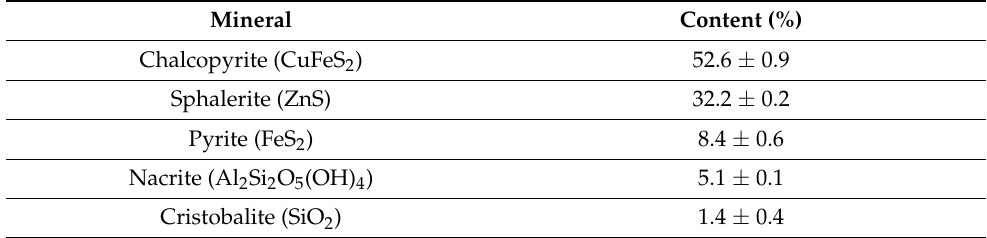
Table 2. XRD analysis of Iberian Pyrite Belt (IPB) sample.